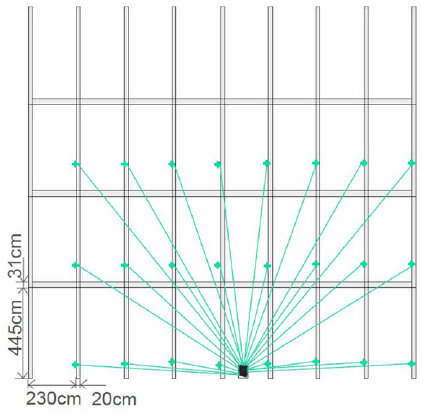
Fig. 5. Distribution of sensor nodes in concrete girder bridge (BS is placed at bottom center)